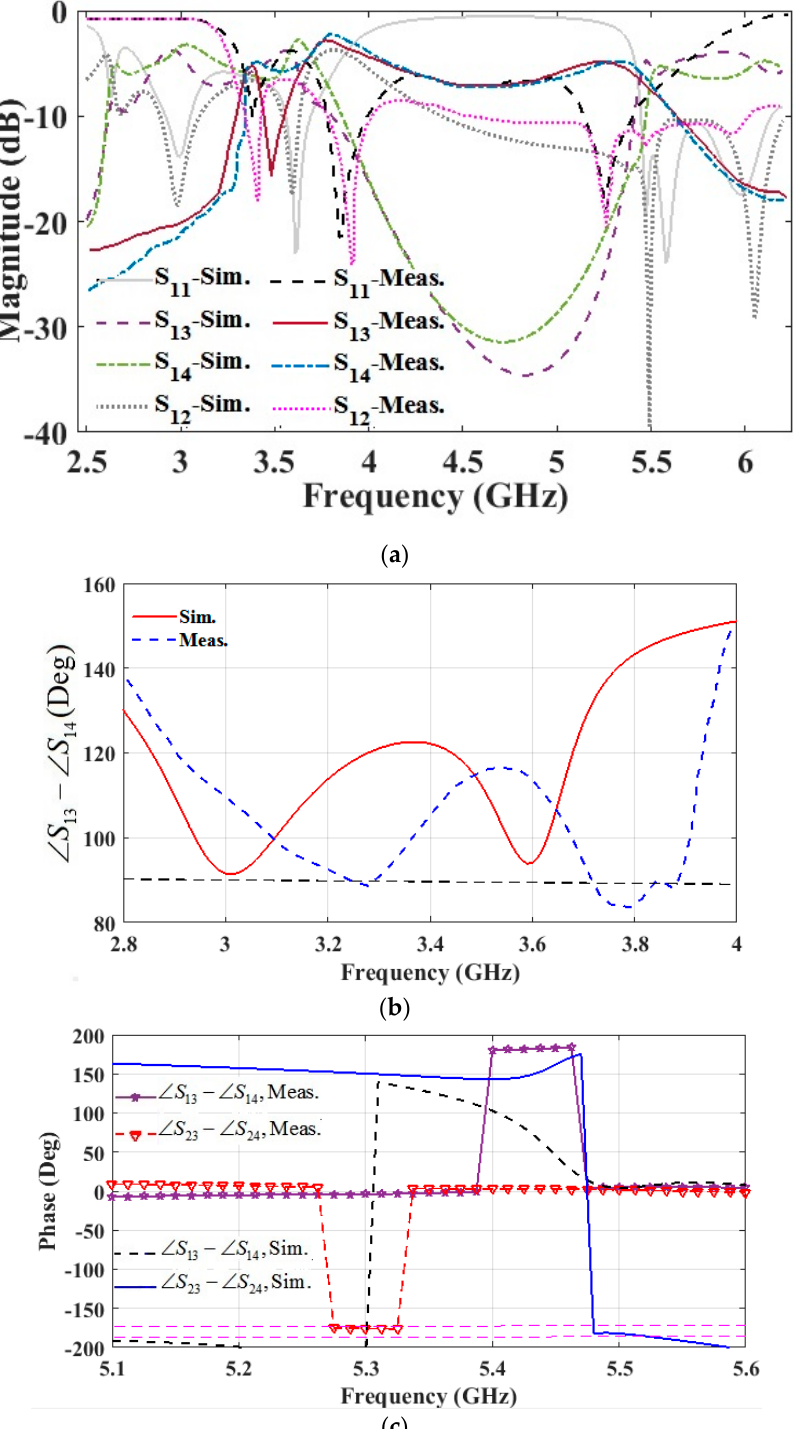
Figure 8. Measured and simulated results of ( a ) the reflection and transmission coefficients amplitude response of the proposed coupler, ( b ) phase difference of dual-mode/dual-band coupler in branch line and ( c ) phase difference of the designed coupler in the